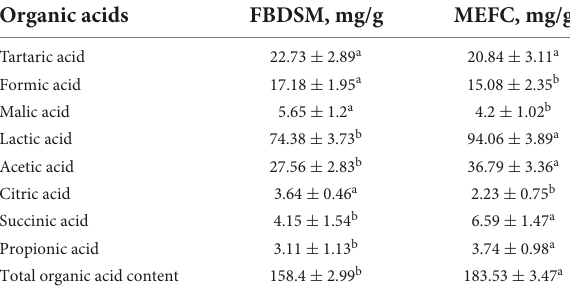
TABLE 4 Organic acid